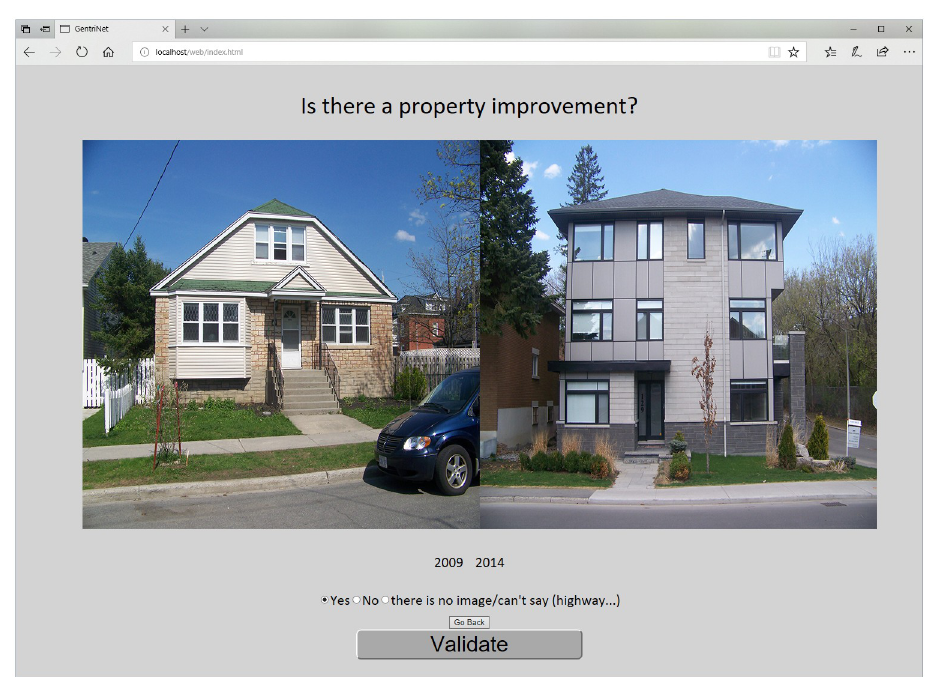
Fig 2. Training data collection web interface. To comply with CC-BY copyright the photos are the author’s and presented for illustrative purposes. The photos are similar to those from GSV.